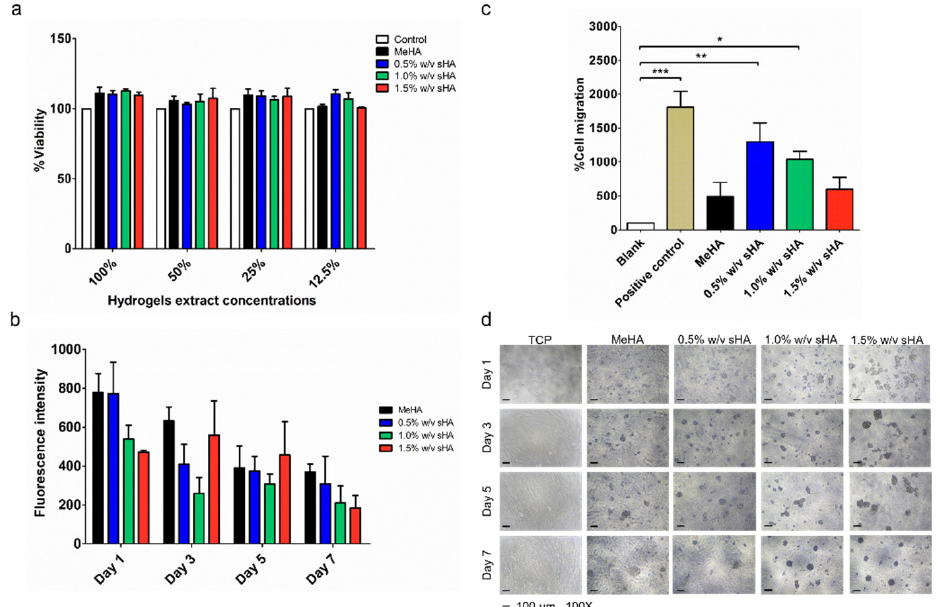
Figure 5. Wound healing activity of hydrogels on PDLs; the hydrogels were tested for their cytocompatibility, indirectly, before being utilized in the other in vitro cell studies ( a ). ( c ) shows the capability of the hydrogels when performing the transwell migration test (for 2 days), serum-free media and serum-contained media were used as a blank and positive control in this study. The significant level of the p value was marked with *, ** and *** which refer to p value ≤ 0.05, 0.01 and 0.001, respectively. The performance of the hydrogels on promoting the proliferation of PDLs (for 7 days) is shown in ( b , d ). ( b ) presents the viability of PDLs, which was indicated and converted into the fluorescence intensity using a resazurin-based solution. ( d ) illustrates the physical appearance of the cells after being cultured on the gels for 7 days.